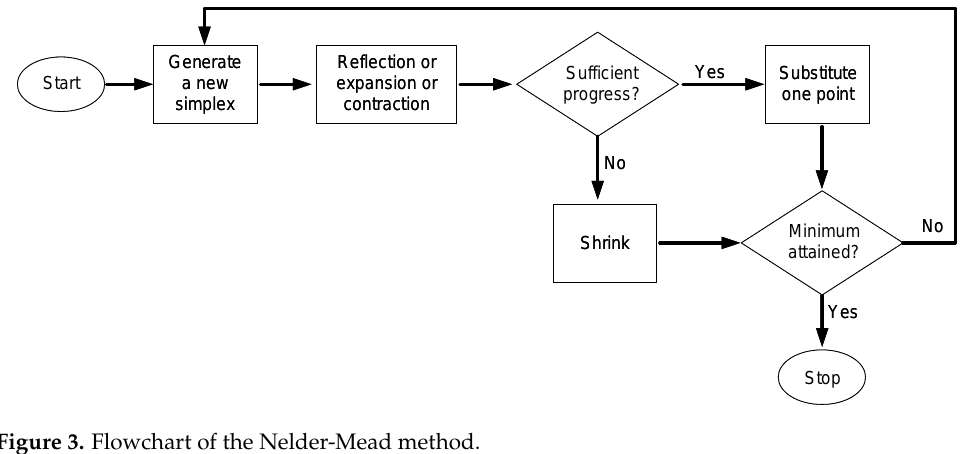
Figure 3. Flowchart of the Nelder-Mead